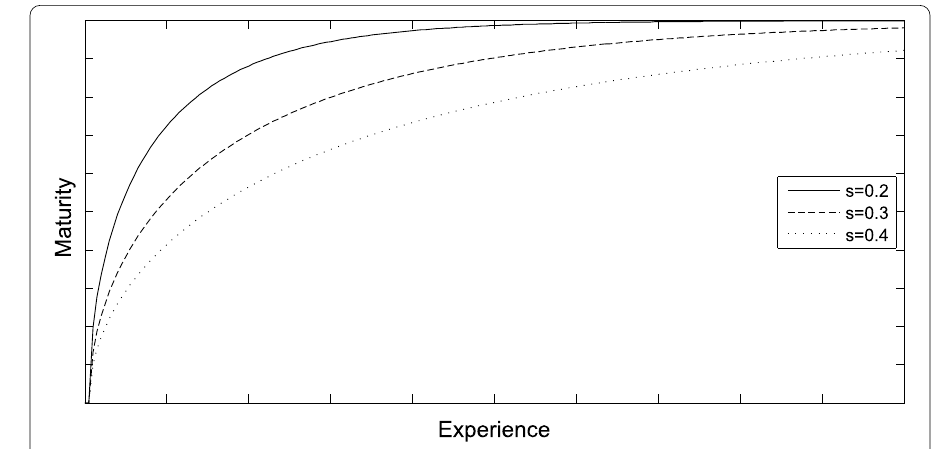
Fig. 5 Relationship between lender experience, risk, and maturity (assuming b = 0.05 )